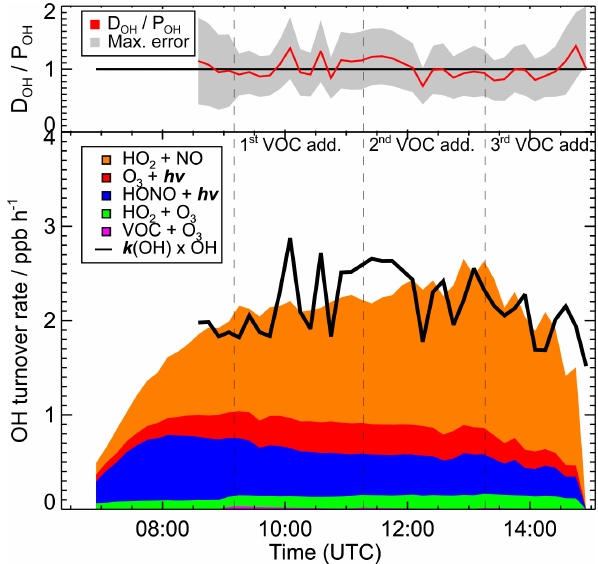
Figure 3. OH budget for the experiment on 27 August 2012. The OH destruction rate D OH calculated from the measured OH reac- tivity k (OH) and the measured OH concentration (DOAS) is given as a black line. The colored areas display the OH production rate P OH calculated from measurements. The upper panel of the dia- gram shows the ratio of D OH /P OH as a red line. The maximum systematic error of the ratio is indicated by the gray area. For rea- sons of clarity all data in the upper as well as the lower panel of the diagram are shown as 5min average values. During the course of the experiment the OH destruction rate is balanced by the sum of the measurable OH production terms. The reaction of HO 2 with NO and the photolysis of HONO are the dominant OH production terms. HO 2 measurements were not corrected for the interference from specific RO 2